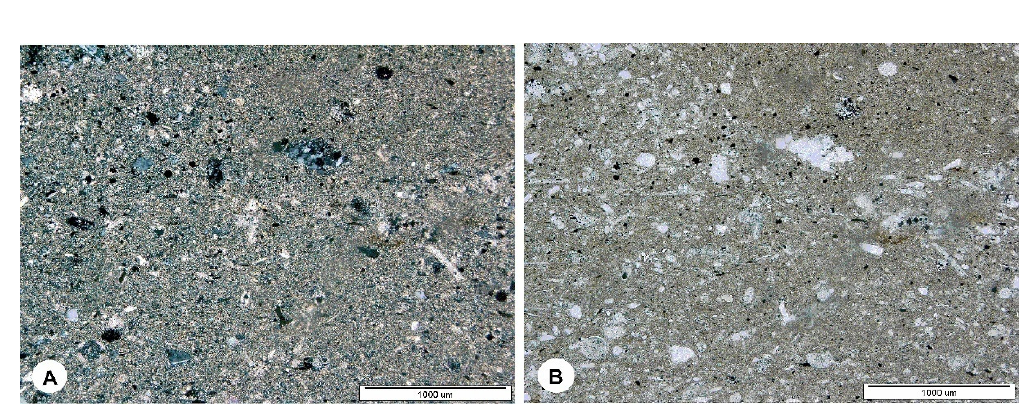
Figure 8. ( A ) Rocky background of the opoka-rock, with visible filling of rocky pores by amorphous silica. Polarizing microscope, 2P; ( B ) Polarizing microscope, 1P.